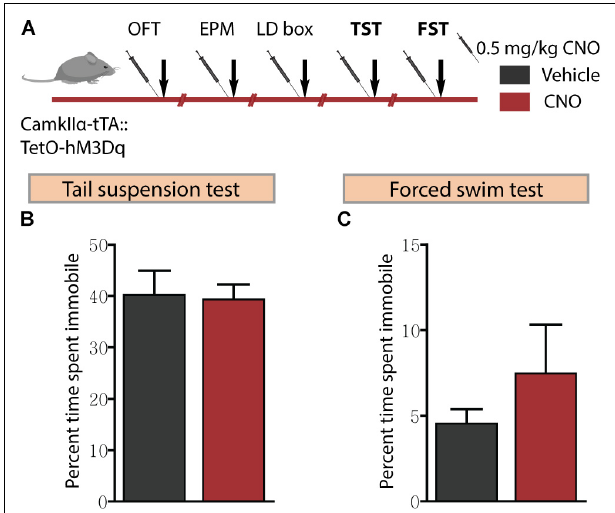
FIGURE 4 | Acute CNO-mediated DREADD activation of CamKII α -positive forebrain excitatory neurons does not influence despair-like behaviour. (A) Shown is a schematic of the experimental paradigm used to determine the influence of acute CNO (0.5 mg/kg)-mediated hM3Dq activation of CamKII α -positive forebrain excitatory neurons in adult male bigenic CamKII α -tTA:TetO-hM3Dq mice on despair-like behaviour. Treatment groups were subjected to the TST and the FST to assess despair-like behaviour, with an interim washout period of 7–10 days ( n = 9–10/group). CNO-mediated hM3Dq DREADD activation of CamKII α -positive forebrain excitatory neurons did not alter despair-like behaviour on either the TST or FST, with no difference noted in percent time spent immobile in the TST (B) and the FST (C) tests, as compared to vehicle-treated CamKII α -tTA:TetO-hM3Dq mice. Results are expressed as the mean ± SEM ( n = 9–10/group), two-tailed, unpaired Student’s t